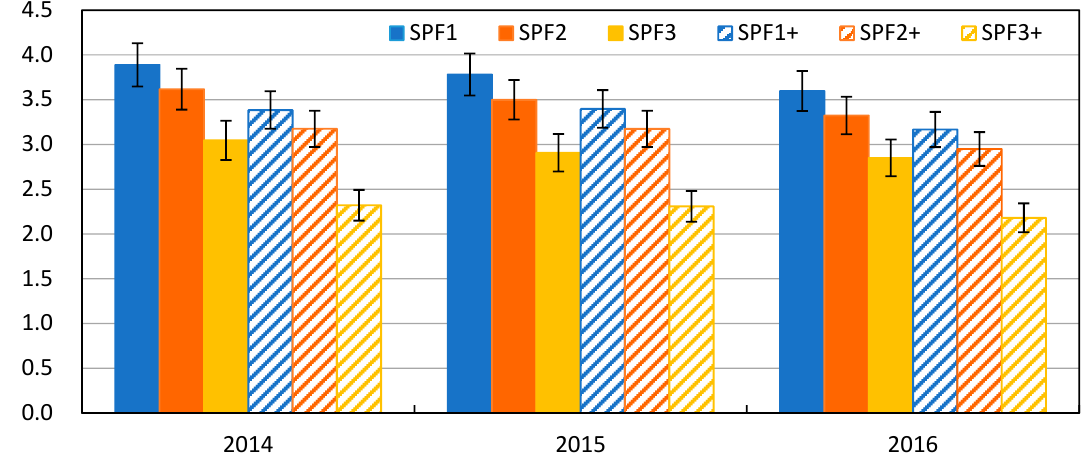
Figure 23. Annual SPF values based on Annex 52 boundaries.